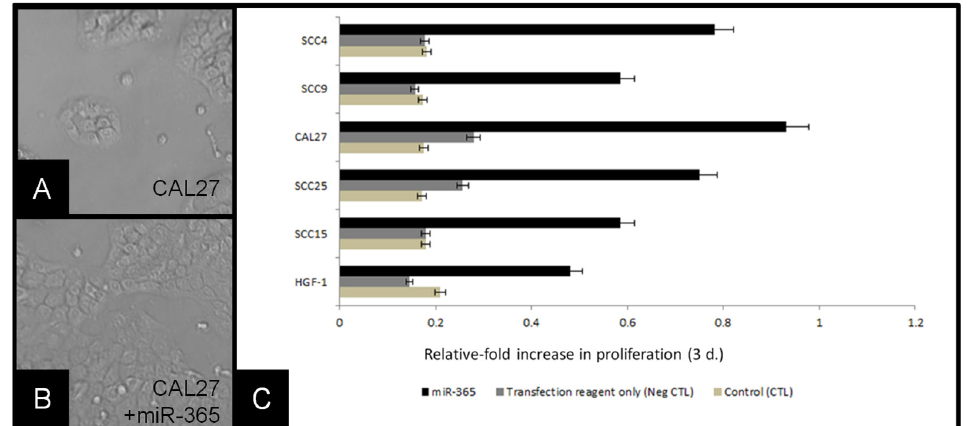
Figure 5. Transfection of cells with miR-365 induced proliferation: ( A ) CAL27 cells in culture, ( B ) CAL27 cells transfected with miR-365, ( C ) molecular confirmation of miR-365 RNA generation, ( D ) relative-fold change in growth of cell lines, compared with baseline (control) and transfection reagent alone (negative control) revealed miR-365 experimental transfection of cell-induced robust changes to proliferation over three days, p = 0.014.